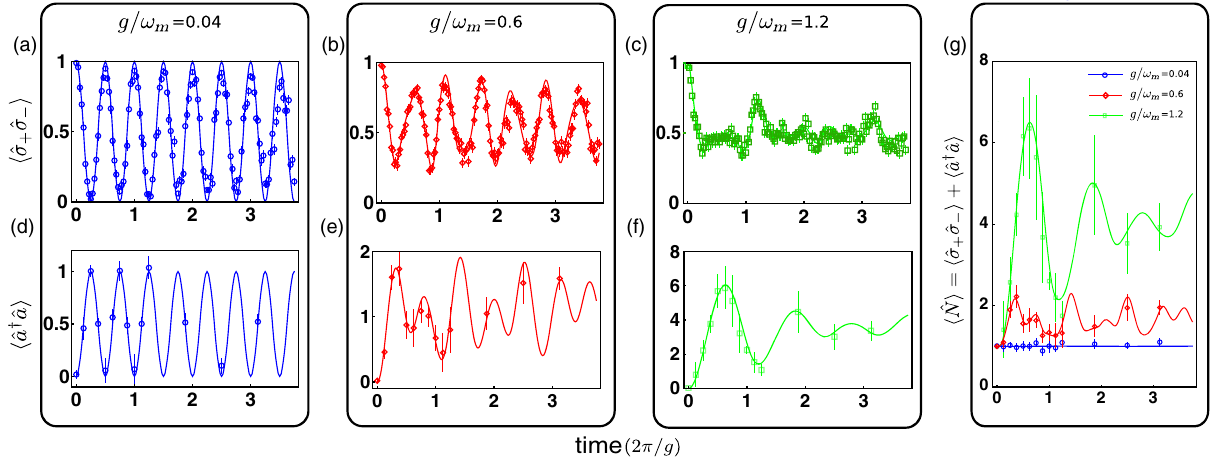
FIG. 1. Spin and phonon dynamics under the QRM for different coupling regimes. Panels (a) – (c) correspond to the population of the 0 . 04 , 0.6, and 1.2, respectively. Panels (d) – (f) correspond to the excited state of the two-level system for the coupling ratios g= ω m ¼ evolution of the average number of phonons for the same coupling ratios. Finally, panel (g) shows the evolution of the total number of excitations for the three cases considered above. In all panels, theoretical predictions are plotted with continuous lines, while dots and their associated error bars represent the experimental data. The lower number of points in the plots of h a † a i is because their measurement process (described in Appendix C) is more